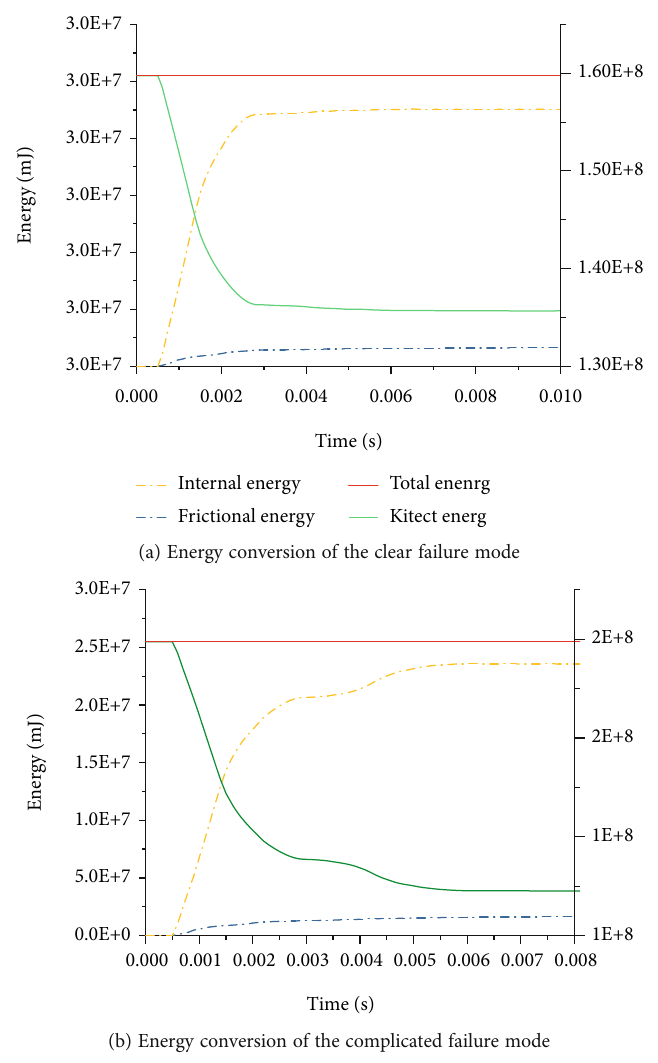
Figure 8: Energy conversion of the shear pin in the fracture process.